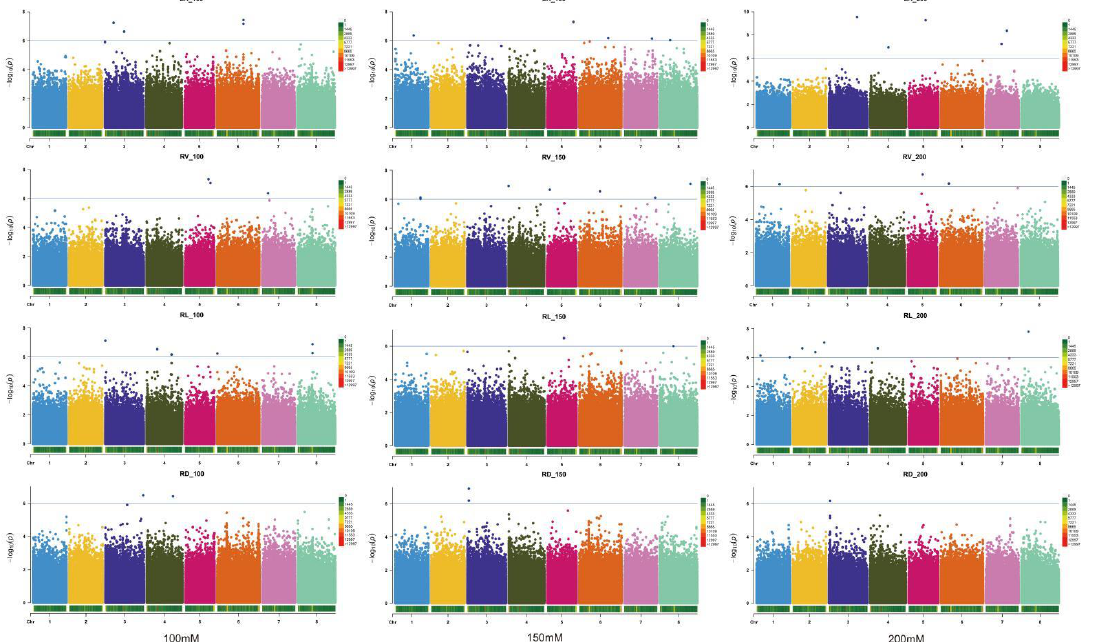
Figure 2. Manhattan plots of marker–trait associations for salt tolerance traits. Significant markers that passed a cutoff log ( p -value) of 6 are above the dot lines. The GWAS was performed using Bayesian-information and Linkage-disequilibrium Iteratively Nested Keyway C software, and the threshold for significantly associated loci was a logarithm of odds score of ≥ 6 (blue line). Different colors represent markers on different chromosomes.